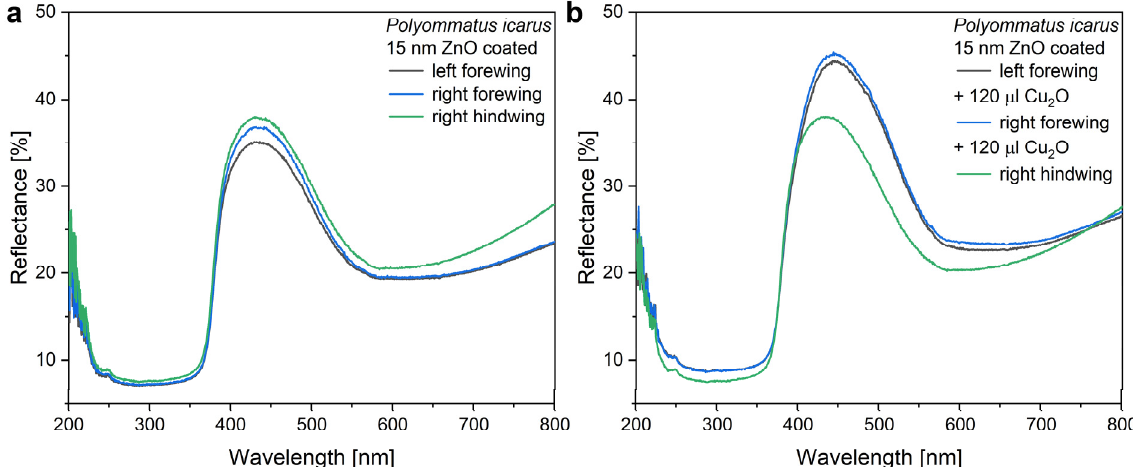
Figure 7. Change in the reflectance of two P. icarus males’ wings conformally covered by 15 nm ZnO after the application of 120 μ L of Cu 2 O sol. ( a ) Reflectance of the 15 nm ZnO coated wings and ( b ) reflectance of the same wings after the application of 120 μ L Cu 2 O sol.